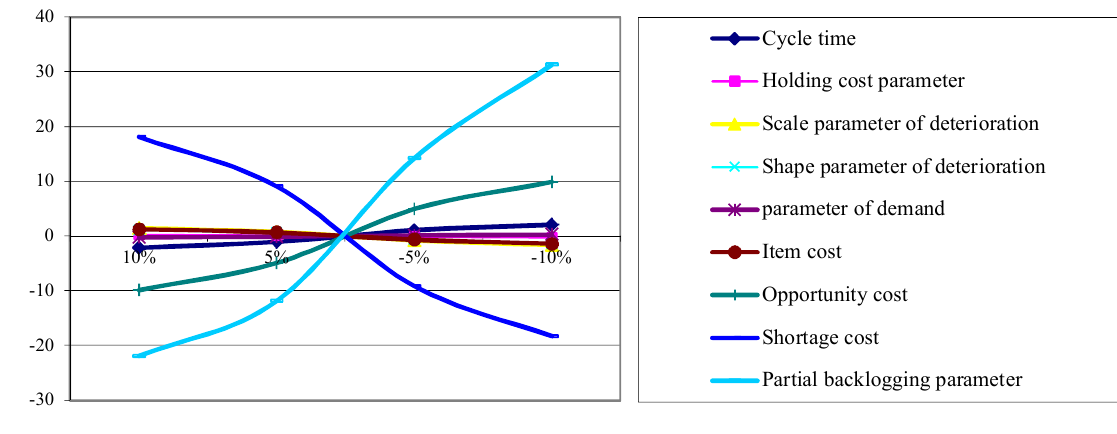
Fig. 5. Behavior of optimal average total cost per unit time in scenario 2